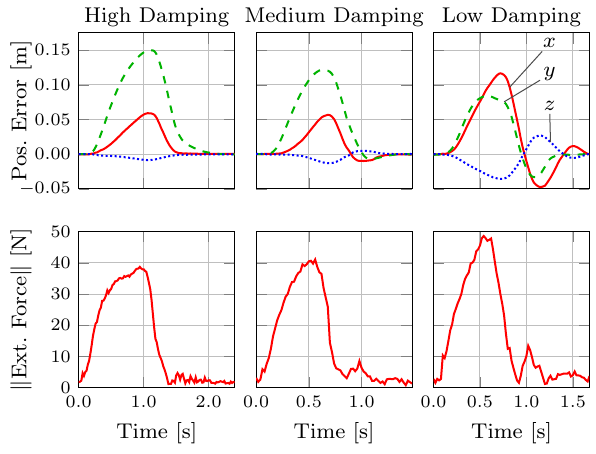
Fig. 13 Cartesian position error of the end-effector of the COMPI manipulator for different controller gains when disturbed by an external force